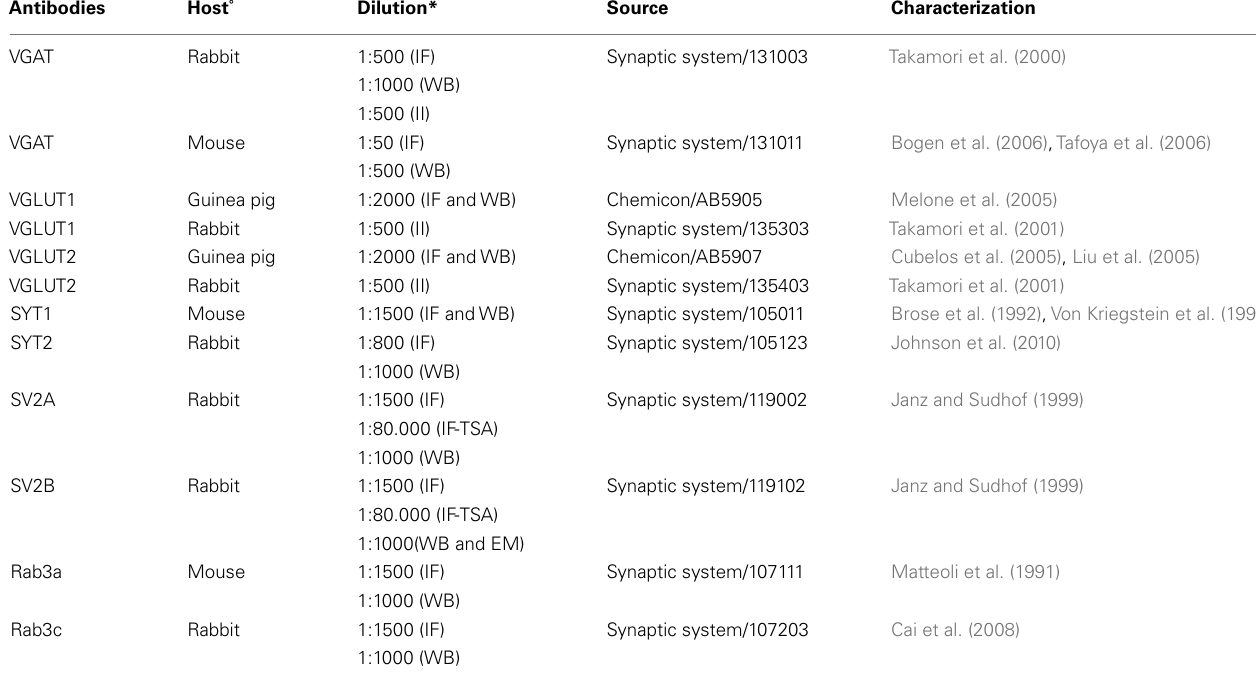
Table 1 | Primary antibodies.